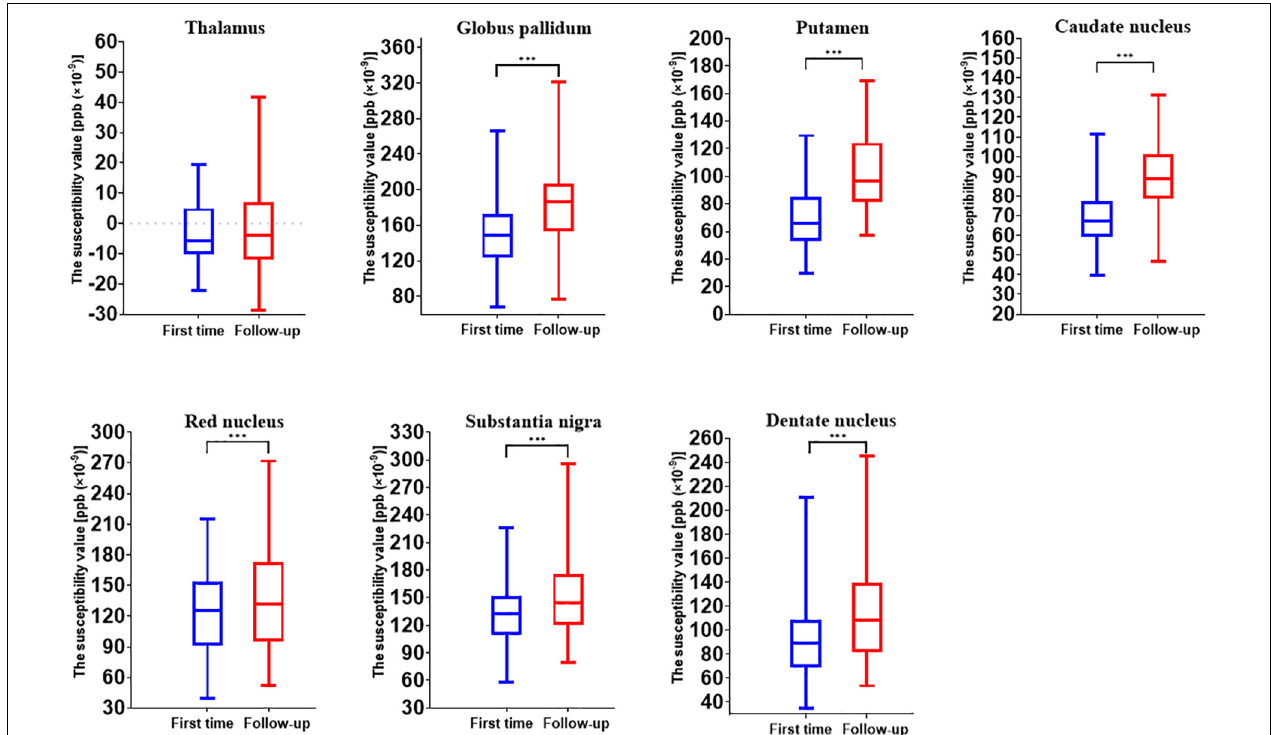
FIGURE 2 | Comparison results of susceptibility values of gray matter nuclei between two time points (first time, July 2010 to December 2011; follow-up, October 2018 to August 2019). *** p < 0 . 001.